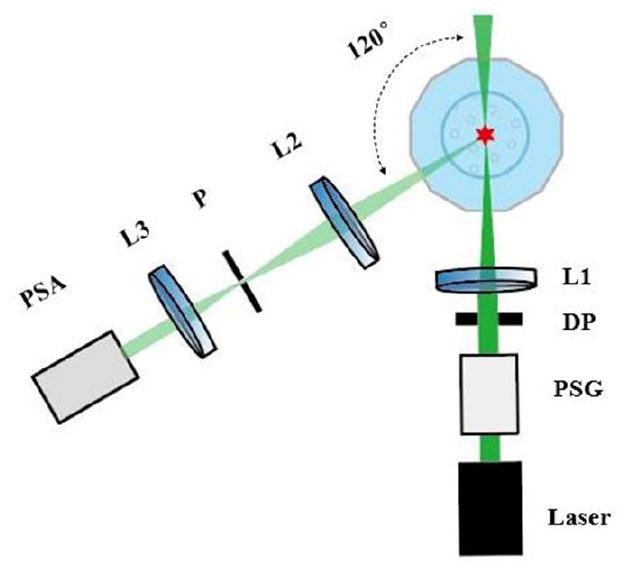
Figure 2. The experimental setup for polarization measurement.